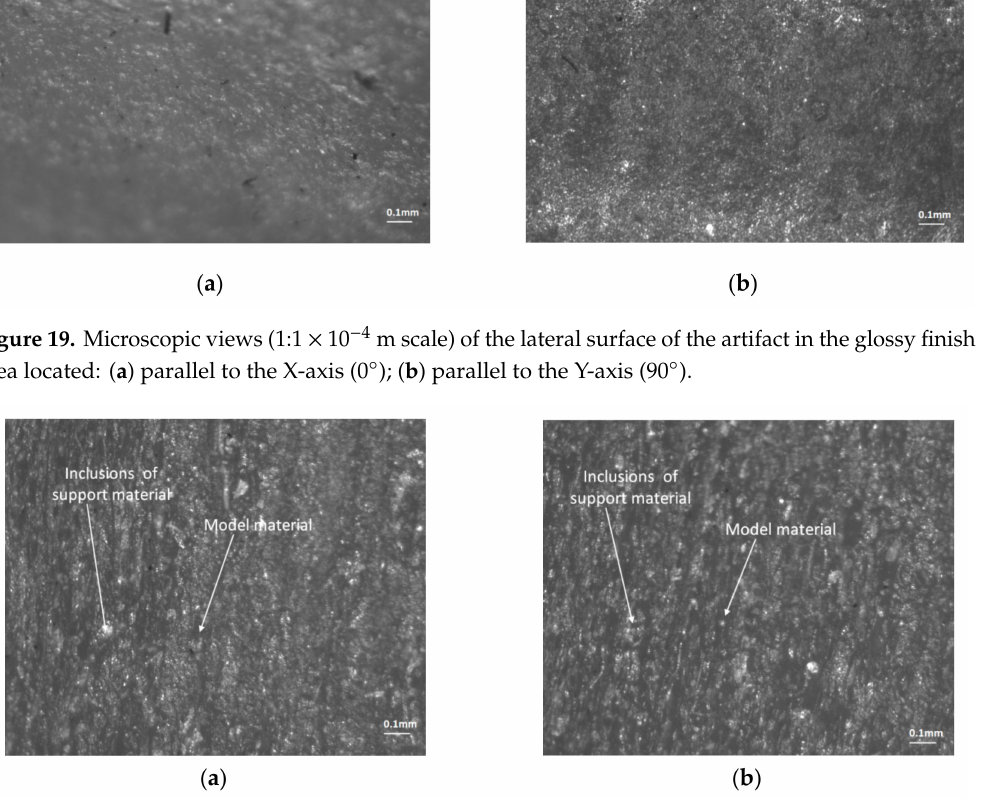
Figure 20. Microscopic views (1:1 × 10 − 4 m scale) on the lateral surface of the artifact, in the matte finish area a ff ected by the support material located: ( a ) parallel to the X-axis (0 ◦ ); ( b ) parallel to the Y-axis (90 ◦